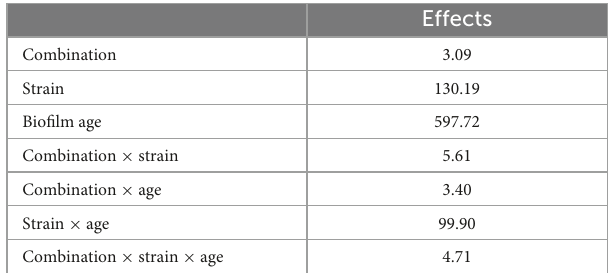
TABLE 4 Standardized statistical effects related to individual and interactive terms of the strain, US treatment, and biofilm age of L. plantarum c19 and DSM 1055.